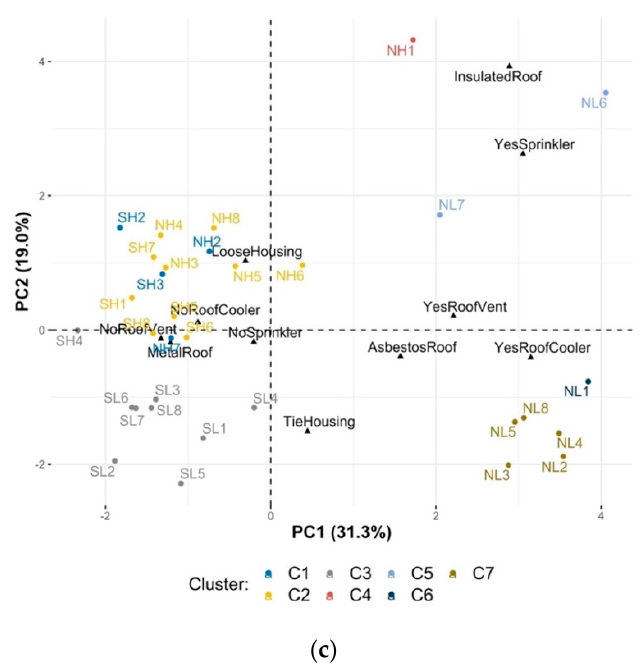
Figure 4. Results of factor analysis (FAMD) and hierarchical clustering on principal components (HCPC) for housing management data. Thirty-two housing conditions (or observations): SL1 to SL8, SH1 to SH8, NL1 to NL8 and NH1 to NH8 represent the housings for lactating cows in the farms numbered from 1 to 8 in south lowland, south highland, north lowland and north highland, respectively. Twelve housing management variables: MatCow, m 2 of mat per cow; FloorCow, m 2 of floor per cow; RidgeHei, ridge roof height (m), EaveHei, eave roof height (m); SideOpen, percent of shed sides open; FanCow, number of fans per cow; HoseCowFloor, times of hosing cow and floor per day; Housing, loose housing (LooseHousing) or tie-up housing (TieHousing); RoTyp, asbestos cement (AsbetosRoof) or sheet metal (MetalRoof); RoofVent, yes (YesRoofVent) if the roof has vent system or no if not (NoRoofVent); Sprinkler, yes (YesSprinkler) if cows are cooled by sprinklers or no if not (NoSprinkler); and RoofCooler, yes (YesRoofCooler) if the roof is cooled by soakers or no if not (NoRoofCooler). ( a ) HCPC—Cluster dendrogram. ( b ) First two PC view of all variables. ( c ) First two PC view of qualitative variables and observations. Table 5. Most significant variables characterising each housing management clusters.